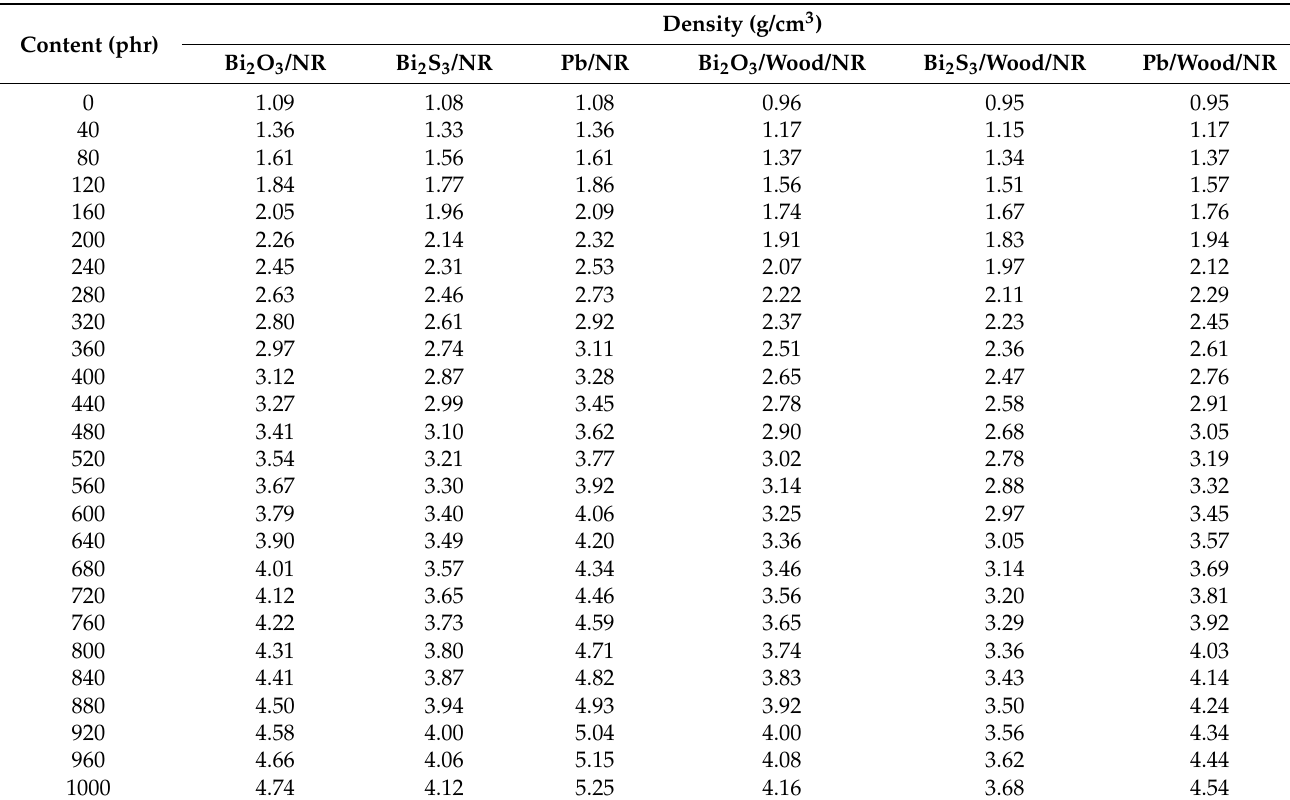
Table 3. Densities of Bi 2 O 3 /NR, Bi 2 S 3 /NR, Pb/NR, Bi 2 O 3 /wood/NR, Bi 2 S 3 /wood/NR, and Pb/wood/NR